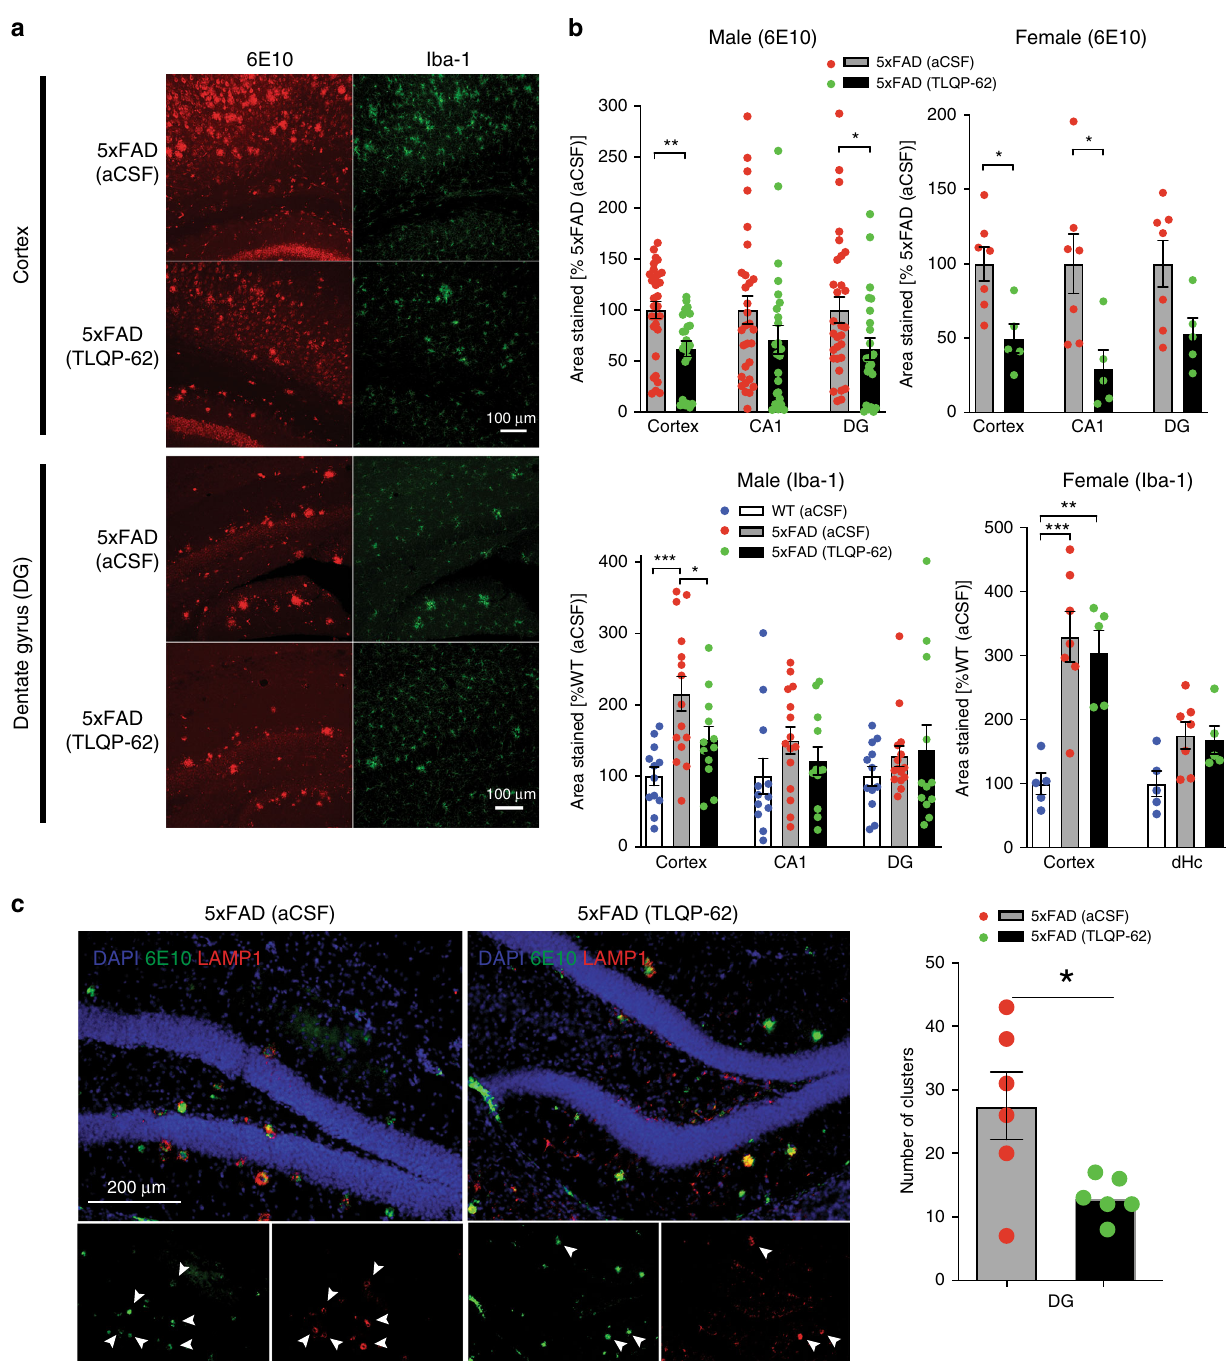
Fig. 7 Chronic i.c.v. administration of TLQP-62 peptide ameliorated pathophysiological changes in the 5xFAD mouse brain. a Immunohistochemical staining of A β amyloid plaques and microglial cells in the male 5xFAD mouse cortex and dentate gyrus after 28-day i.c.v. administration of TLQP-62 peptide or vehicle control (aCSF). Red: A β (6E10), green: Iba-1. b Quanti fi cation of percent area of A β and Iba-1 staining in both peptide-treated male and female 5xFAD mouse brains. Data are presented as mean percentage ± SEM. Results of A β (6E10) staining were analyzed by two-sided Student ’ s t test. Male: cortex, p = 0.0015; DG p = 0.0316; female: cortex, p = 0.0101; CA1, p = 0.022. Iba-1 staining were analyzed by one-way ANOVA with Newman – Keuls post hoc analysis, male cortex: F (2,36) = 8.449, p = 0.001, n = 4, 5, 4 mice per group, 3 slices analyzed per animal; female cortex: F (2,14) = 12.53, p = 0.0008, n = 5, 7, 5 mice per group, * p < 0.05, ** p < 0.01, *** p < 0.001. c Reduced staining of Lamp1-immunoreactive dystrophic neurite